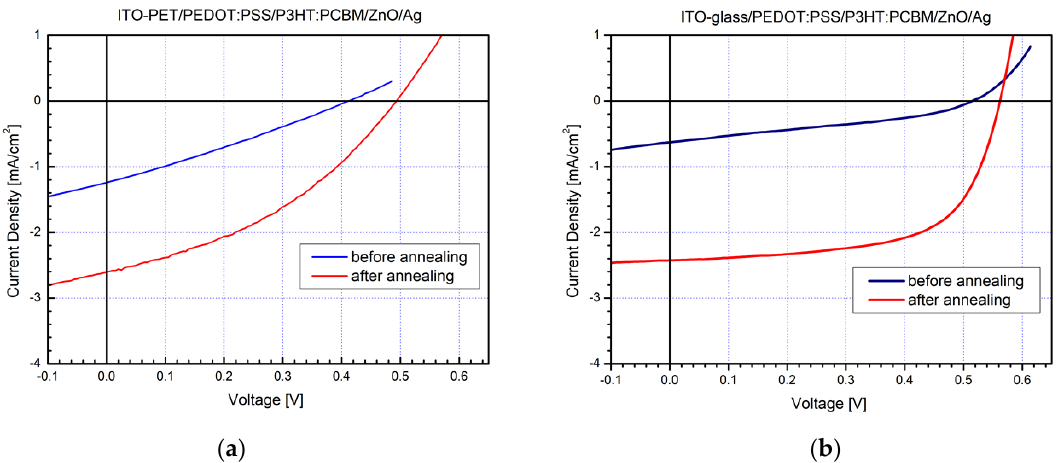
Figure 4. I–V characteristics of P3HT:PCBM-based solar cells with ZnO nanoparticles ETL constructed under environmental conditions on: ( a ) flexible PET substrates and ( b ) glass